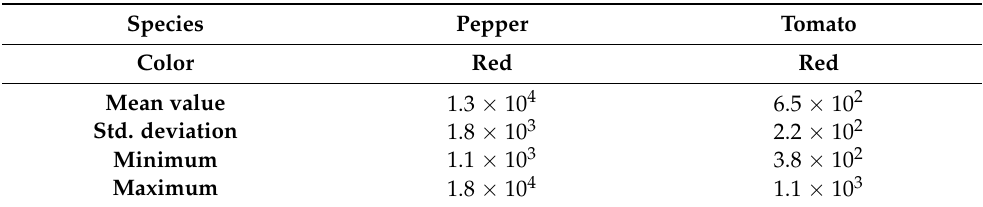
Table 2. Intra-fruit variations of Raman band intensities at 1500 cm − 1 measured as triplicates on 5 spots each on a hot pepper and